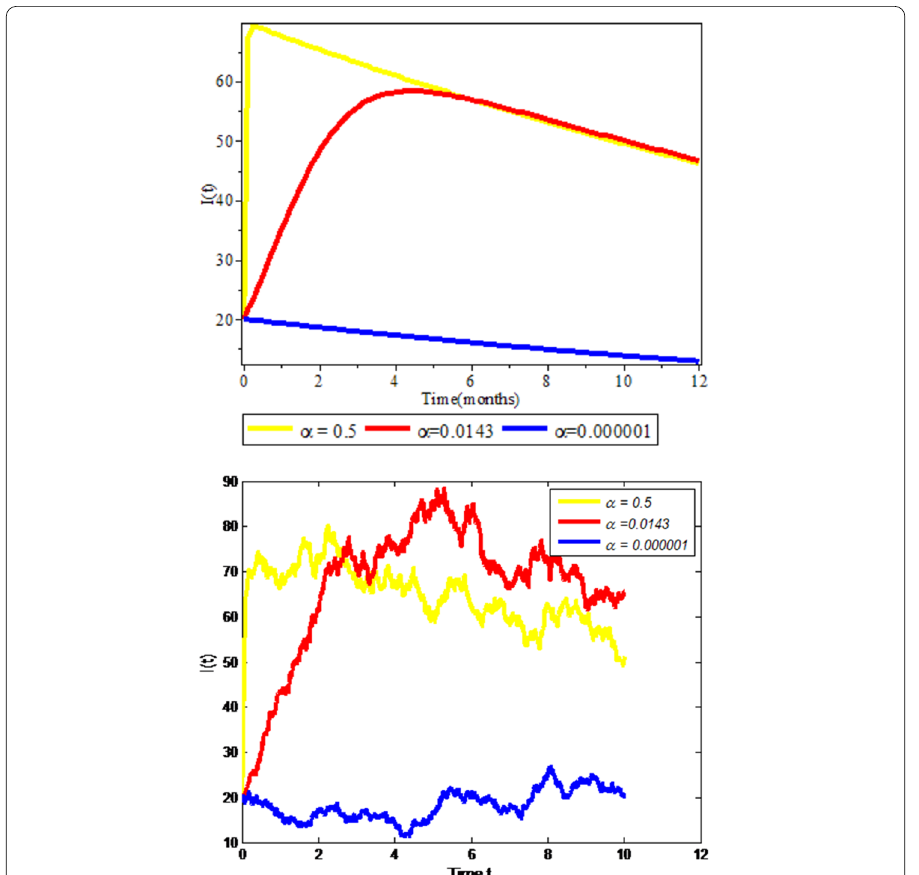
Figure 3 Effect of contact rate on COVID-19